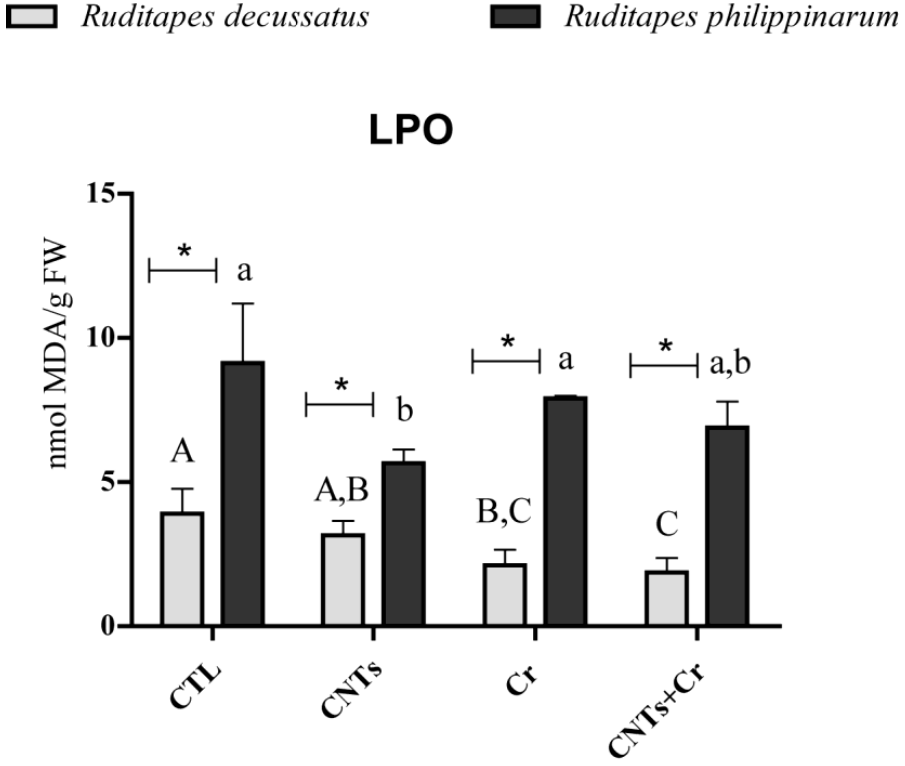
Figure 2. Lipid peroxidation (LPO) levels (mean values + standard deviation), in Ruditapes decussatus (light gray bars) and Ruditapes philippinarum (dark gray bars) after a 28-day exposure period. For each species, tested treatments were: control (CTL), carbon nanotubes (CNTs), chromium (Cr), and the combination of both contaminants (CNTs + Cr). Significant differences ( p < 0.05) among treatments are represented with different letters (lowercase for R. decussatus and uppercase for R. philippinarum ). For each treatment, significant differences ( p < 0.05) between R. decussatus and R. philippinarum are represented with an asterisk (*).